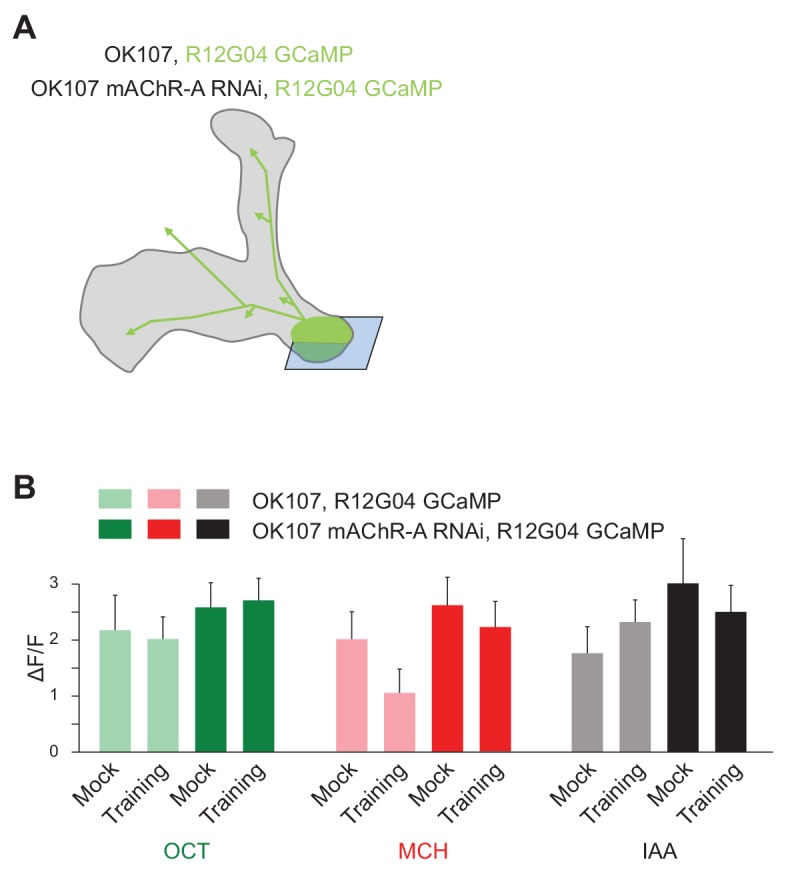
Diagram and additional data for Figure 8 (mAChR-A knockdown prevents learning-associated depression of odor responses in MVP2).(A) Diagram of genotype: mAChR-A RNAi 1 was expressed in KCs with OK107 (gray), while GCaMP6f was expressed in MB-MVP2 with R12G04-LexA (green). The imaging plane is shown in blue. (B) Absolute ∆F/F values from MB-MVP2 corresponding to the ratios shown in Figure 8B. Odors and genotypes as in Figure 8B. No general depression was observed following RNAi expression. (mean ± SEM; n = 5, p>0.05 for all mock vs. trained comparisons, Mann-Whitney tests). The difference between mock vs. trained for MCH in control flies is not statistically significant because of variability in overall responsiveness to odors between flies. When MCH responses are normalized to OCT responses as in Figure 8B, the difference is statistically significant.